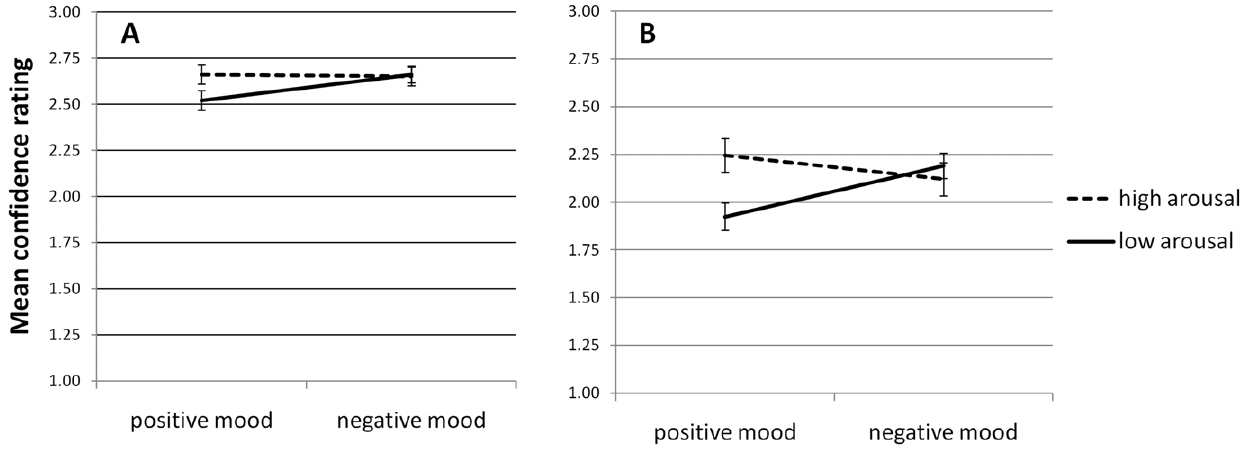
Figure 4. Confidence ratings during (A) ‘correct rejection’ and (B) ‘hit’ trials. The lowest confidence ratings were observed during the positive mood/low arousal